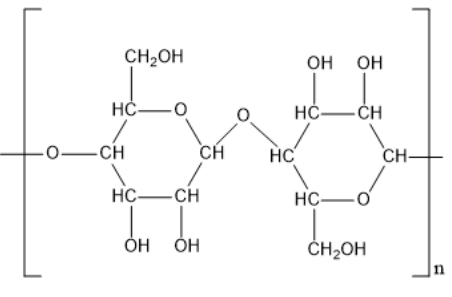
Figure 6. The molecular structure of cellulose.